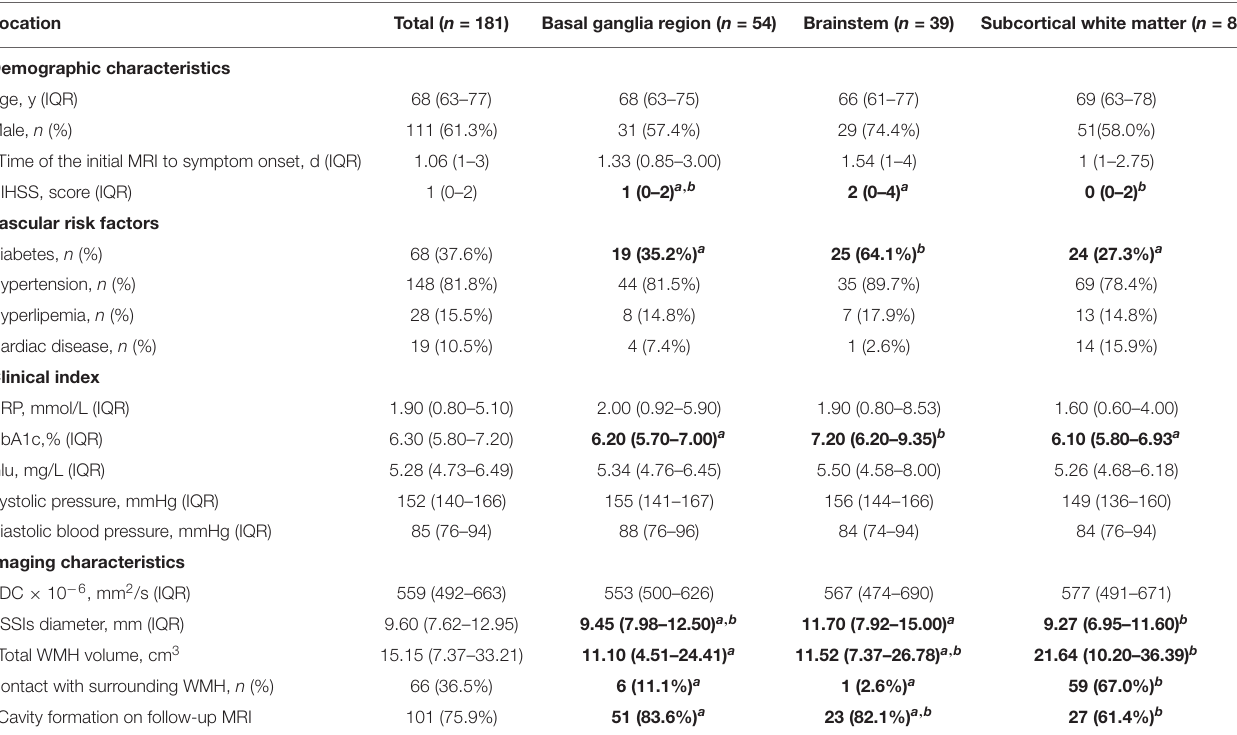
TABLE 1 | Clinical data and MRI findings of baseline RSSIs according to location.